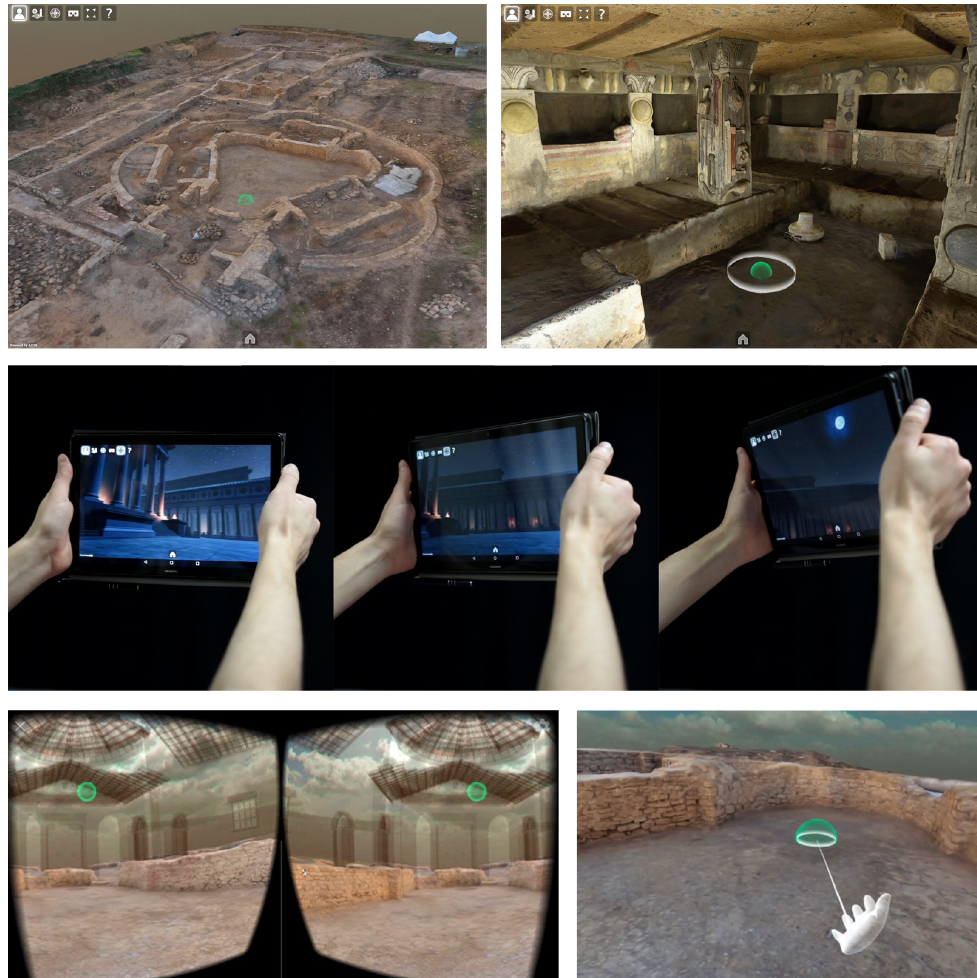
Figure 9. Different navigation modes. Top row : orbit (left) and first person (right); Middle row : device orientation mode; Bottom row : sample immersive view-aligned query/pointing on 3-DoF devices like cardboards (bottom left) and through 6-DoF VR controllers for locomotion on high-end HMDs (bottom